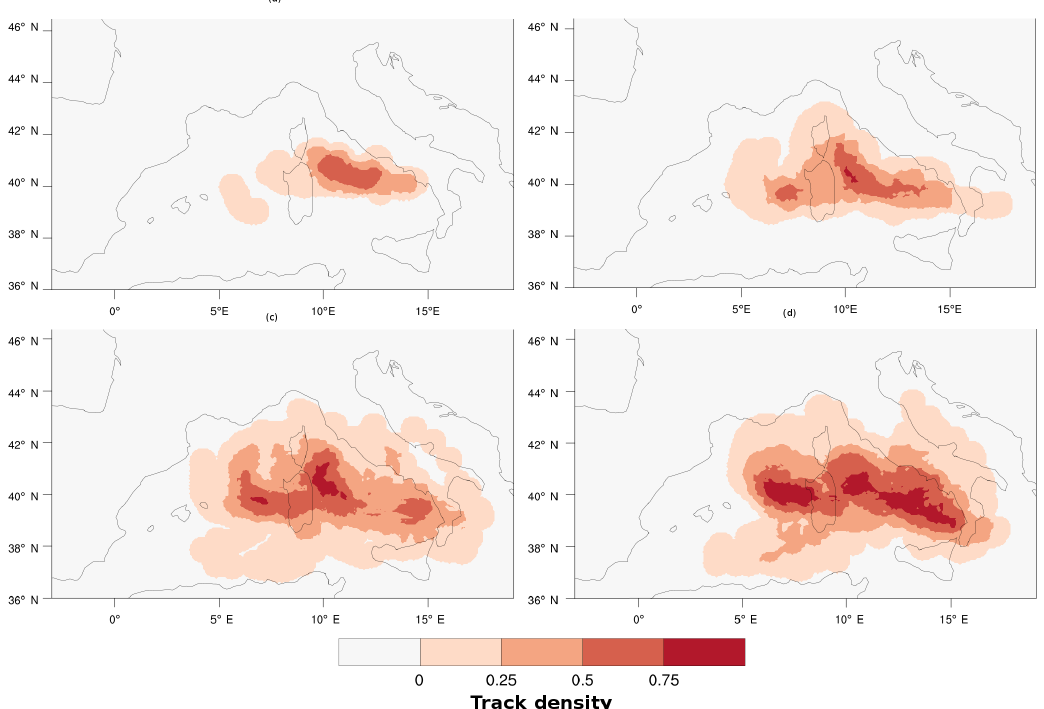
Figure 4. Track densities based on all cyclones classified as medicanes for an SST change of (a) − 3K, (b) 0K (original SSTs), (c) + 3K and (d) +